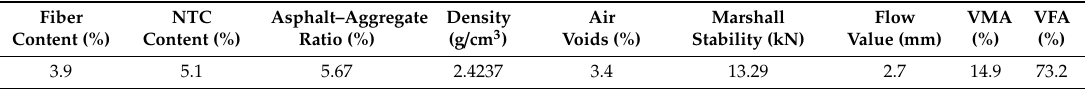
Table 17. Model optimization factor and prediction index values.